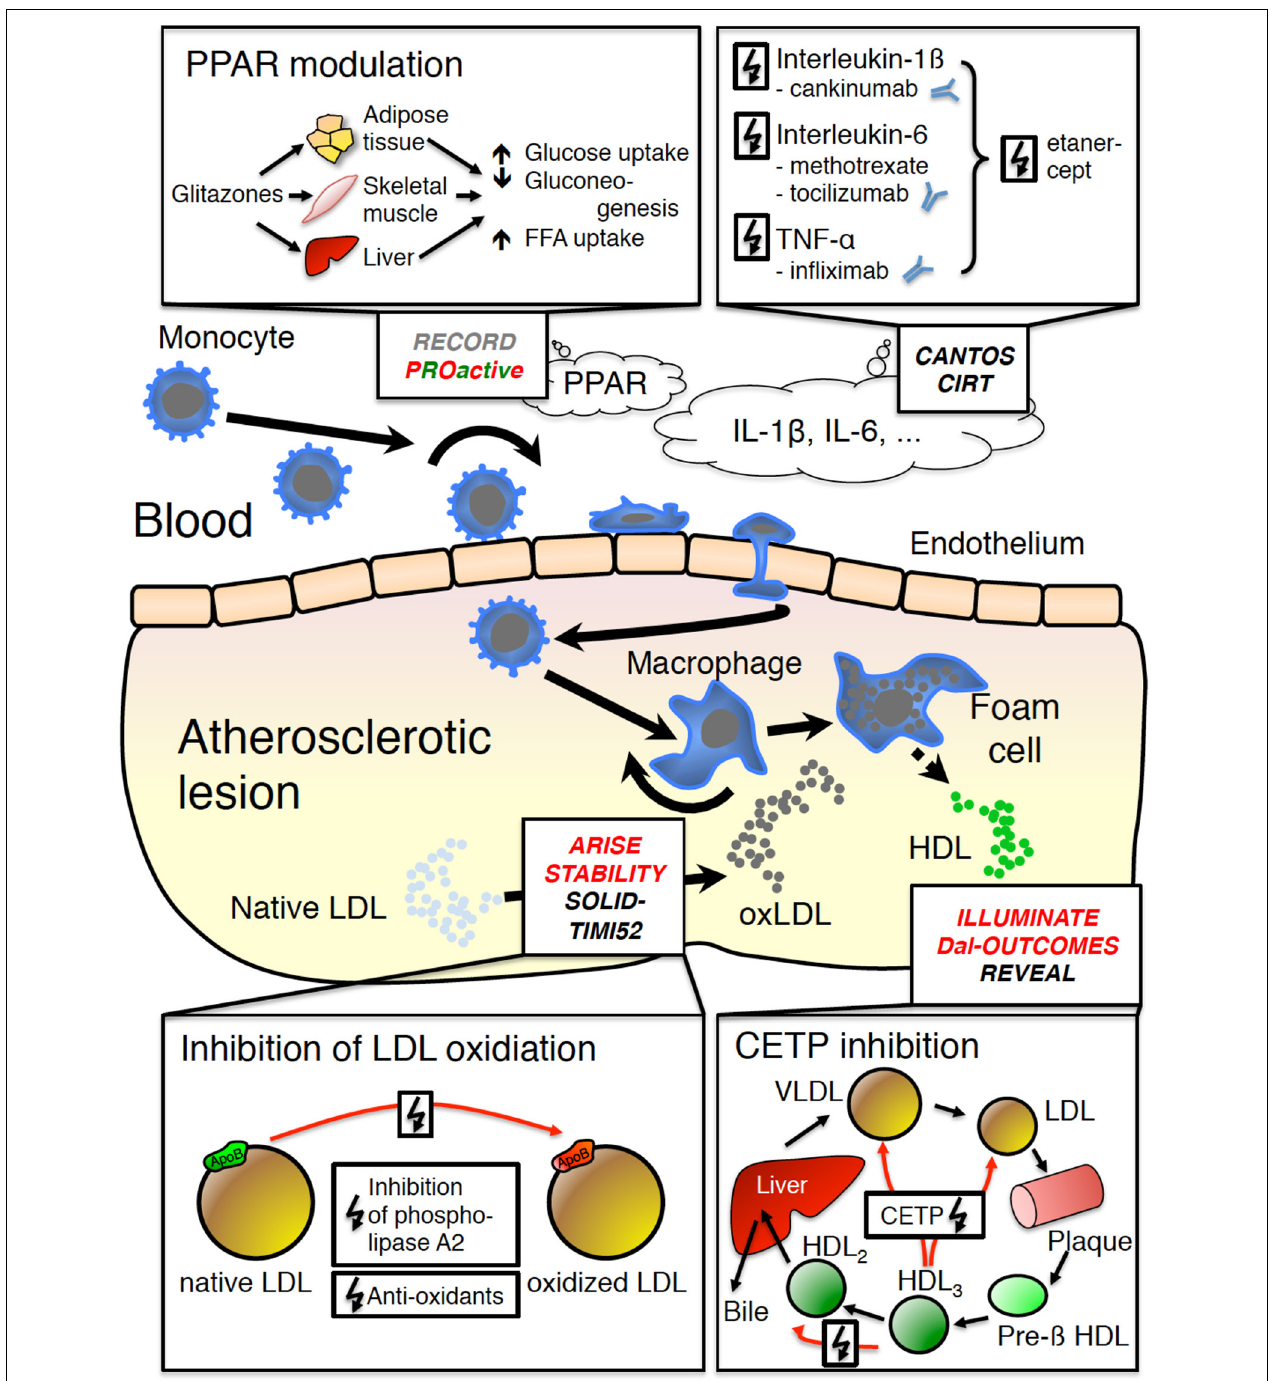
FIGURE 1 | Basic mechanisms of atherogenesis and studies specifically targetinginflammationinatherogenesis. Briefly,bloodmonocytesenterthe subendothelial space where they differentiate toward macrophages and foam cells, which in turn secrete pro-inflammatory mediators leading to further inflammation, plaque growth and eventually plaque rupture. RECORD (rosiglitazone) and PROActive (pioglitazone) have studied the role of peroxysome proliferator-activated receptor- γ (PPAR γ ) agonists, which increase insulin sensitivity, glucose and free fatty acid (FFA) uptake, while reducing gluconeogenesis including anti-inflammatory effects. CANTOS (canakinumab) and CIRT (low dose methotrexate) target IL-1 β or IL-6. ARISE (succinobucol),